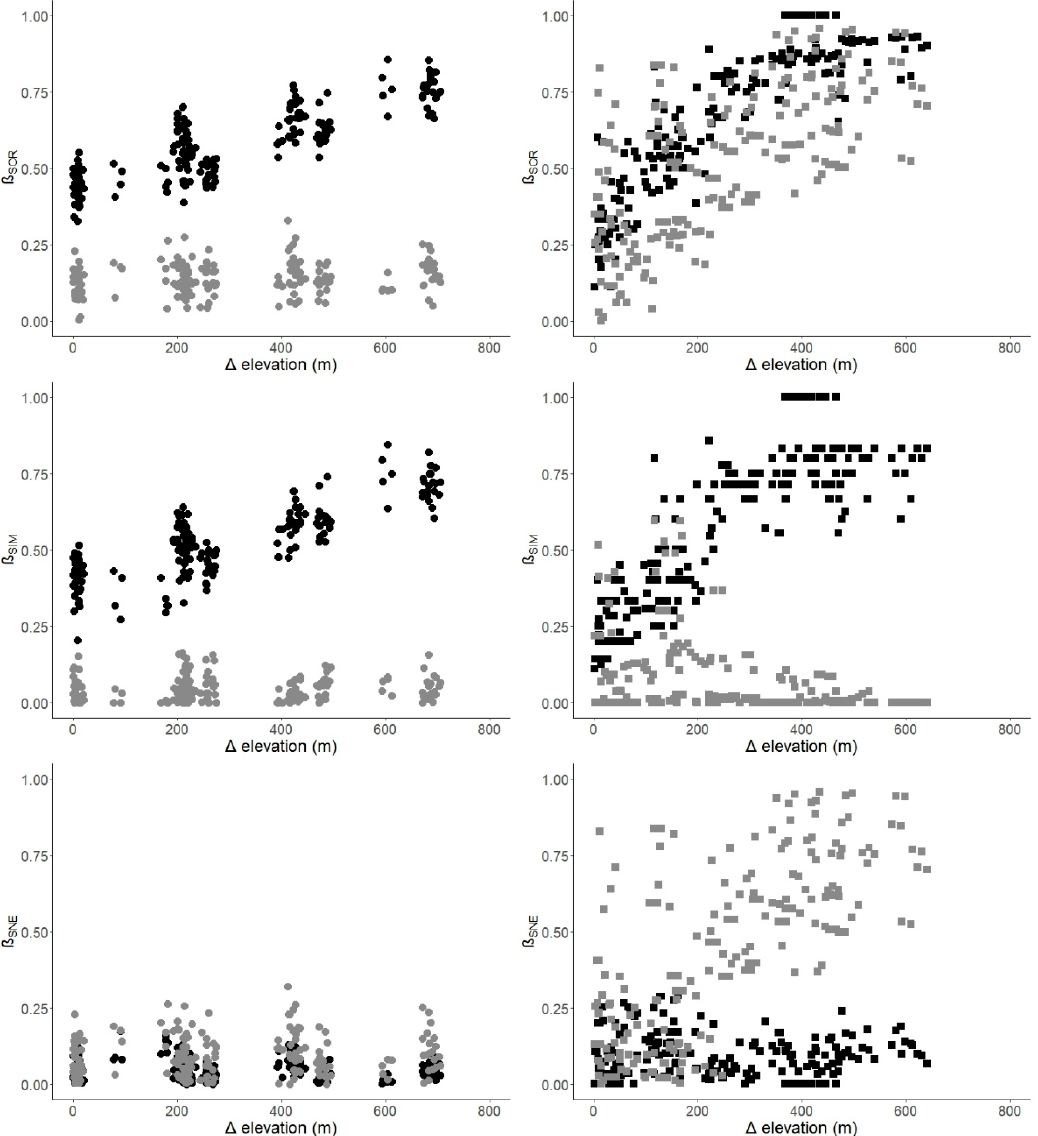
Figure 4. Pairwise taxonomic (black) and functional (gray) dissimilarities versus elevational distances between pairs of plots in Mengla (left, circles) and Ailaoshan (right, squares). β SOR = Sørensen dissimilarity index or total dissimilarity; β SIM = Simpson index or turnover-resultant dissimilarity; β SNE = nestedness-resultant